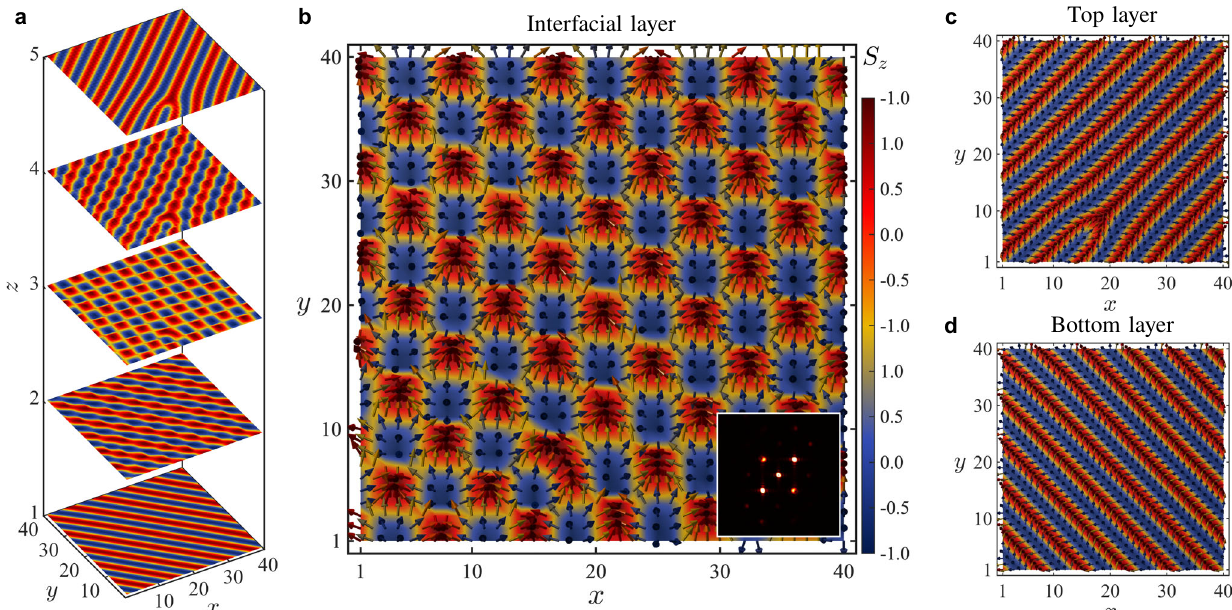
Fig. 2 Checkerboard skyrmion crystal. a Plot of the z -component of the spin S z , obtained via MC annealing, in a fi ve-layer heterostructure. b Spin con fi guration of the frustration-stabilized checkerboard skyrmion crystal (CSkX) at the central layer ( z = 3). c and d are the canonical spin spirals at the top layer ( z = 5) and the bottom layer ( z = 1), oriented along mutually-orthogonal diagonals. Inset in b shows the central layer spin structure factor S ( q ) within the fi rst Brillouin zone, revealing a double- q magnetic order. The parameters used are D = J , A = 0, J = 1 (both top and bottom